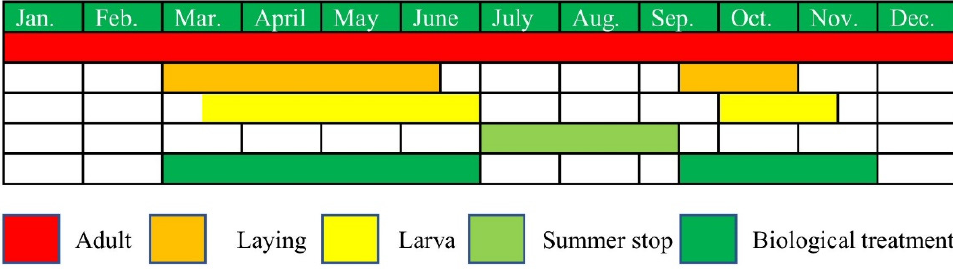
Figure 3. Diagram of the upper third of the crown of Eucalyptus globulus where the degree of defo- liation is assessed. The degree of defoliation was evaluated by the observer, where possible, the same person, according to the five levels or degrees of defoliation agreed in the group meetings (Table 3 and Figure 4). Table 3. Degrees of defoliation according to the GOSSGE protocol . Degree of Defoliation Tree Crown Damage 0